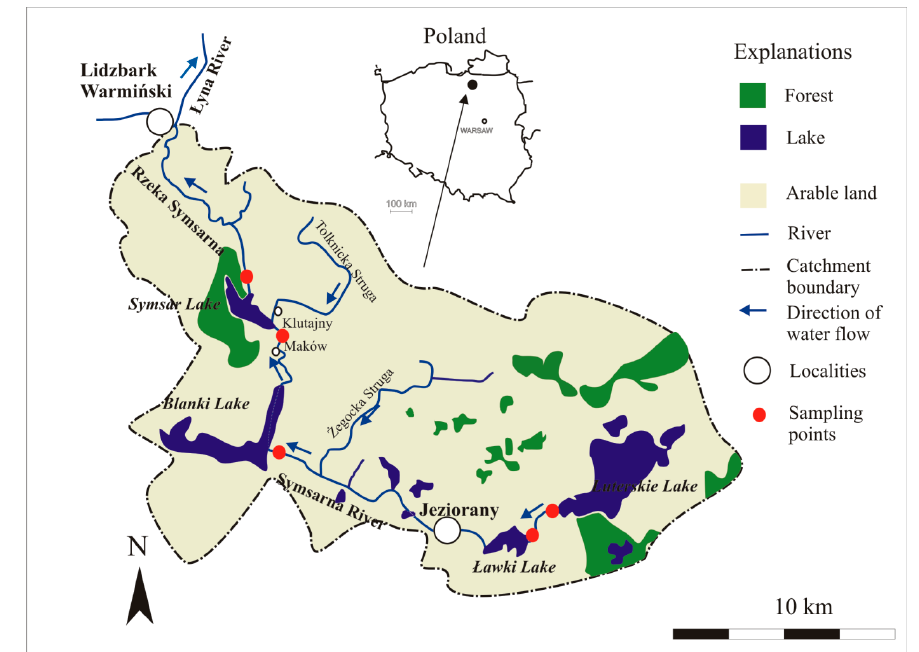
Figure 2. Location of sampling points.